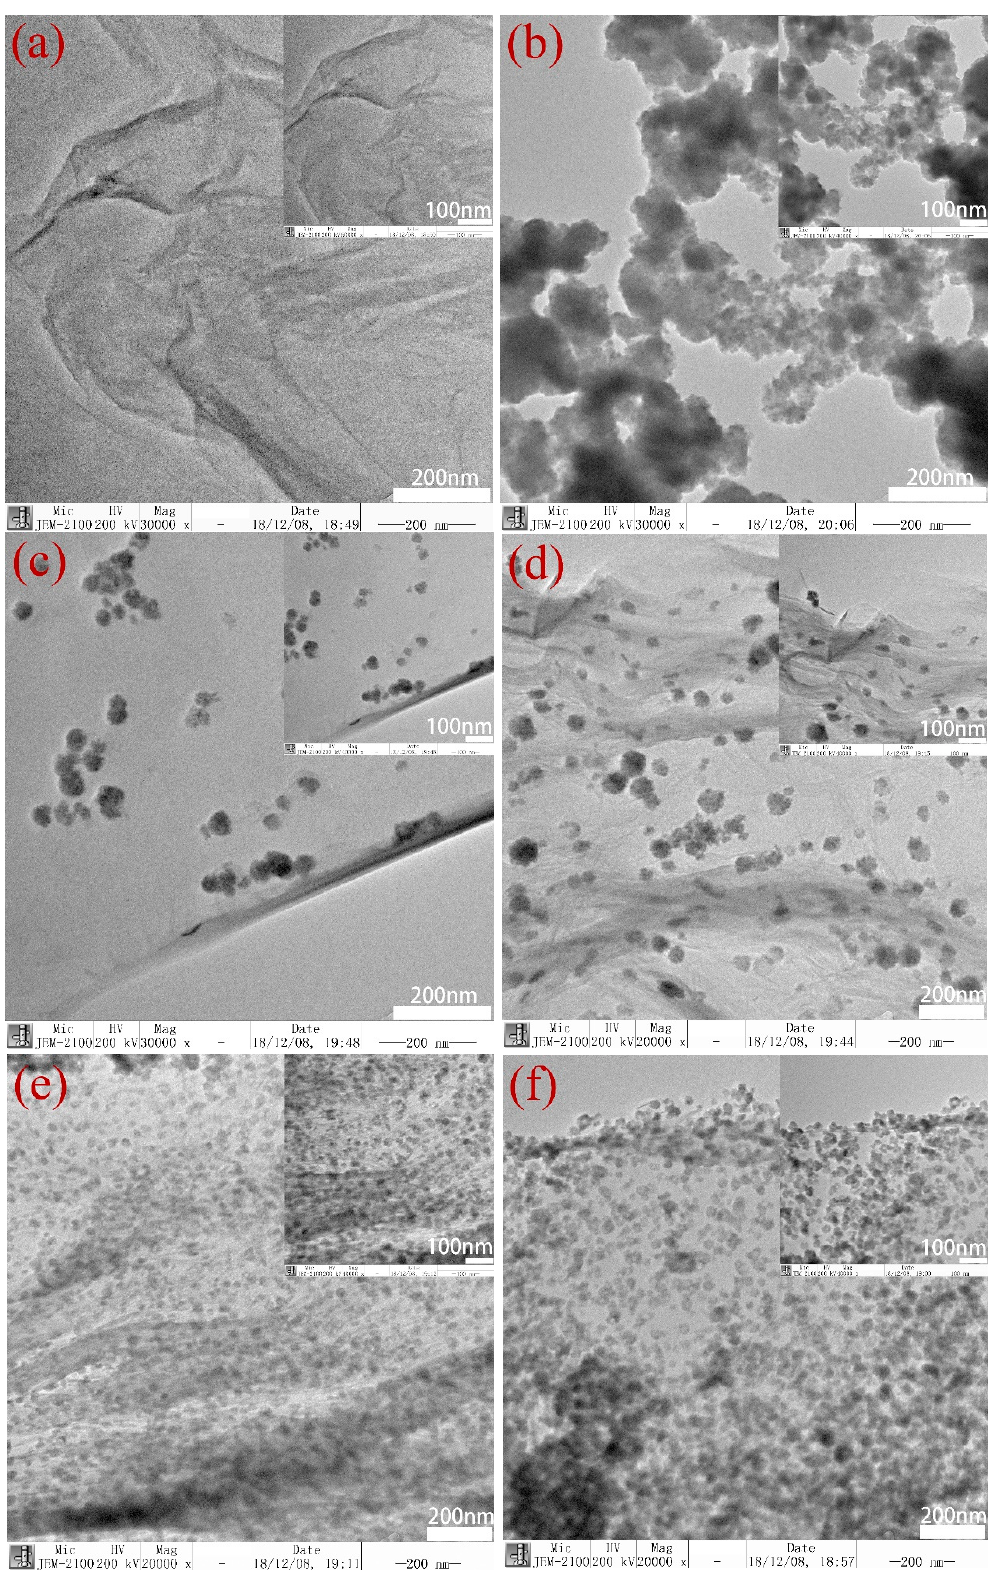
Figure 4. TEM images of GO ( a ), CdSe ( b ), CdSe/RGO-1:0.5 ( c ), CdSe/RGO-1:1 ( d ), CdSe/RGO-1:1.5 ( e ), CdSe/RGO-1:2 ( f ).